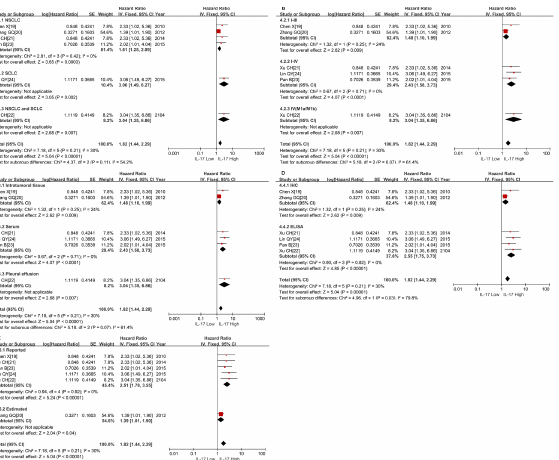
Fig 6. Meta-analysis between IL-17 overexpression and overall survival (OS) of lung cancer stratified by histological type (A), tumor stage (B), detection specimen (C), test method (D) and method to obtain HR (E). The individualand pooledHR with 95% CI was shown by forest plot. HR > 1 impliedworse OS for the group with high IL-17 expression.